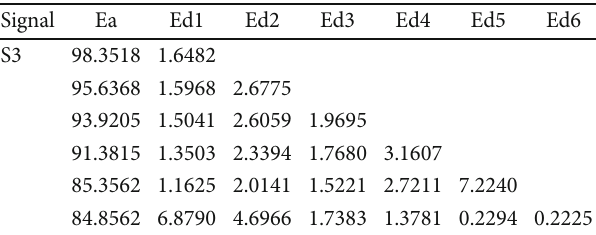
Table 3: Energy distribution computation for the DWT of frequency range of